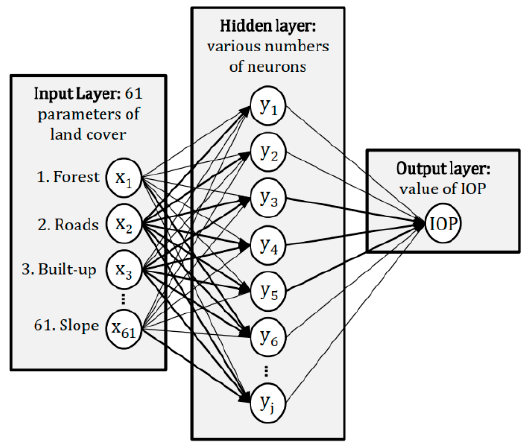
Figure 6. Structure of used neural network. Figure 6 . Structure of used neural network. Figure 6 . Structure of used neural network. Figure 6 . Structure of used neural network. Figure 6 . Structure of used neural network. Figure 6 . Structure of used neural network.